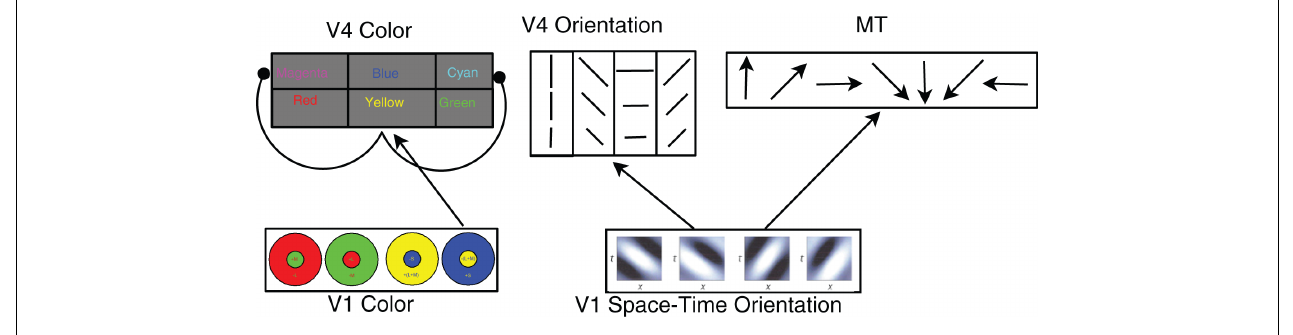
Magenta and Cyan excitatory groups (arrows with circular heads).The feed-forward connectivity is similar for Red, Green, and Blue. Cyan and Magenta receive feed-forward connections from twoV1 layers: Green, Blue and Red, Blue (respectively).TheV1 space–time orientation layer contains 28 space–time oriented filters at three spatial resolutions at each spatial location.These filters are converted into Poisson spike trains and project to MT andV4 Orientation neurons. See text for connectivity